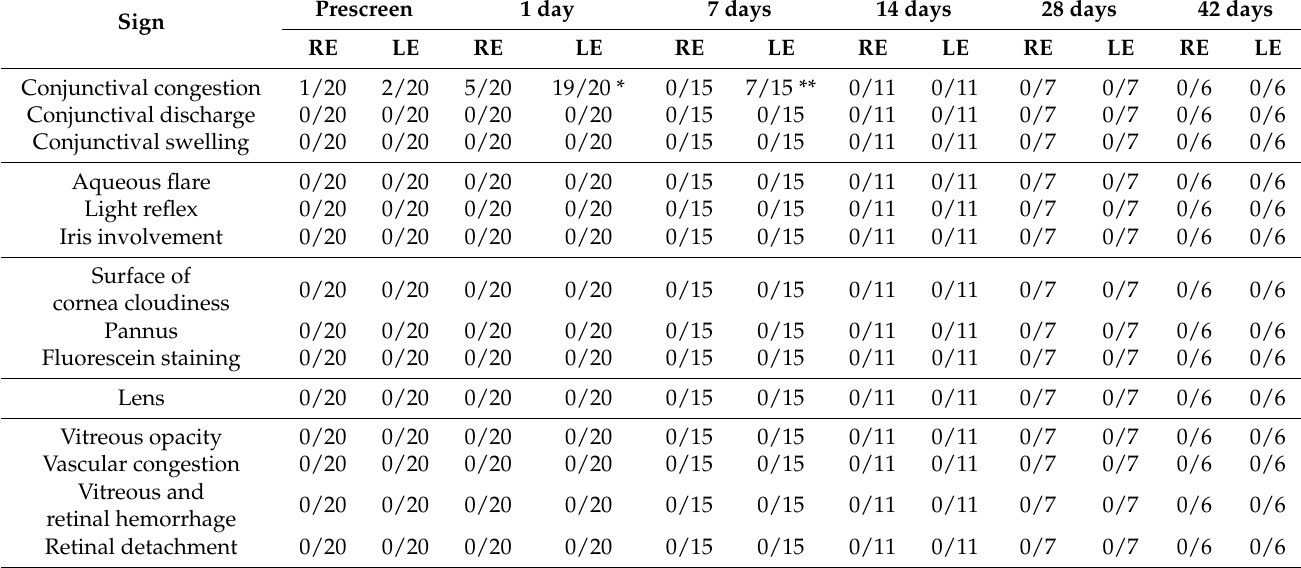
Table 5. Summary of ophthalmic clinical observations (anterior and posterior segment). Rabbits received a single sub-Tenon injection of Dx-loaded microspheres in the left eye (LE). The right eye (RE) was used as the